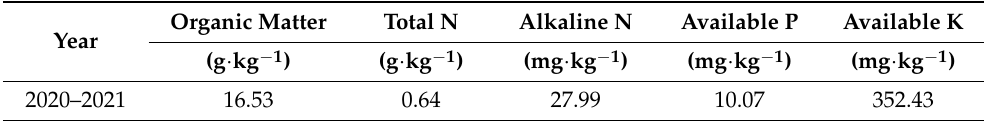
Figure 1. Monthly accumulated rainfall (( A ), mm), monthly accumulated total solar radiation (( B ), MJ·m − 2 ), and monthly mean temperature (( C ), °C) during the winter wheat growing season (October to June) in 2020 – 2021. Table 1. Chemical properties of the experimental field soil before N treatment. Table 1. Chemical properties of the experimental field soil before N